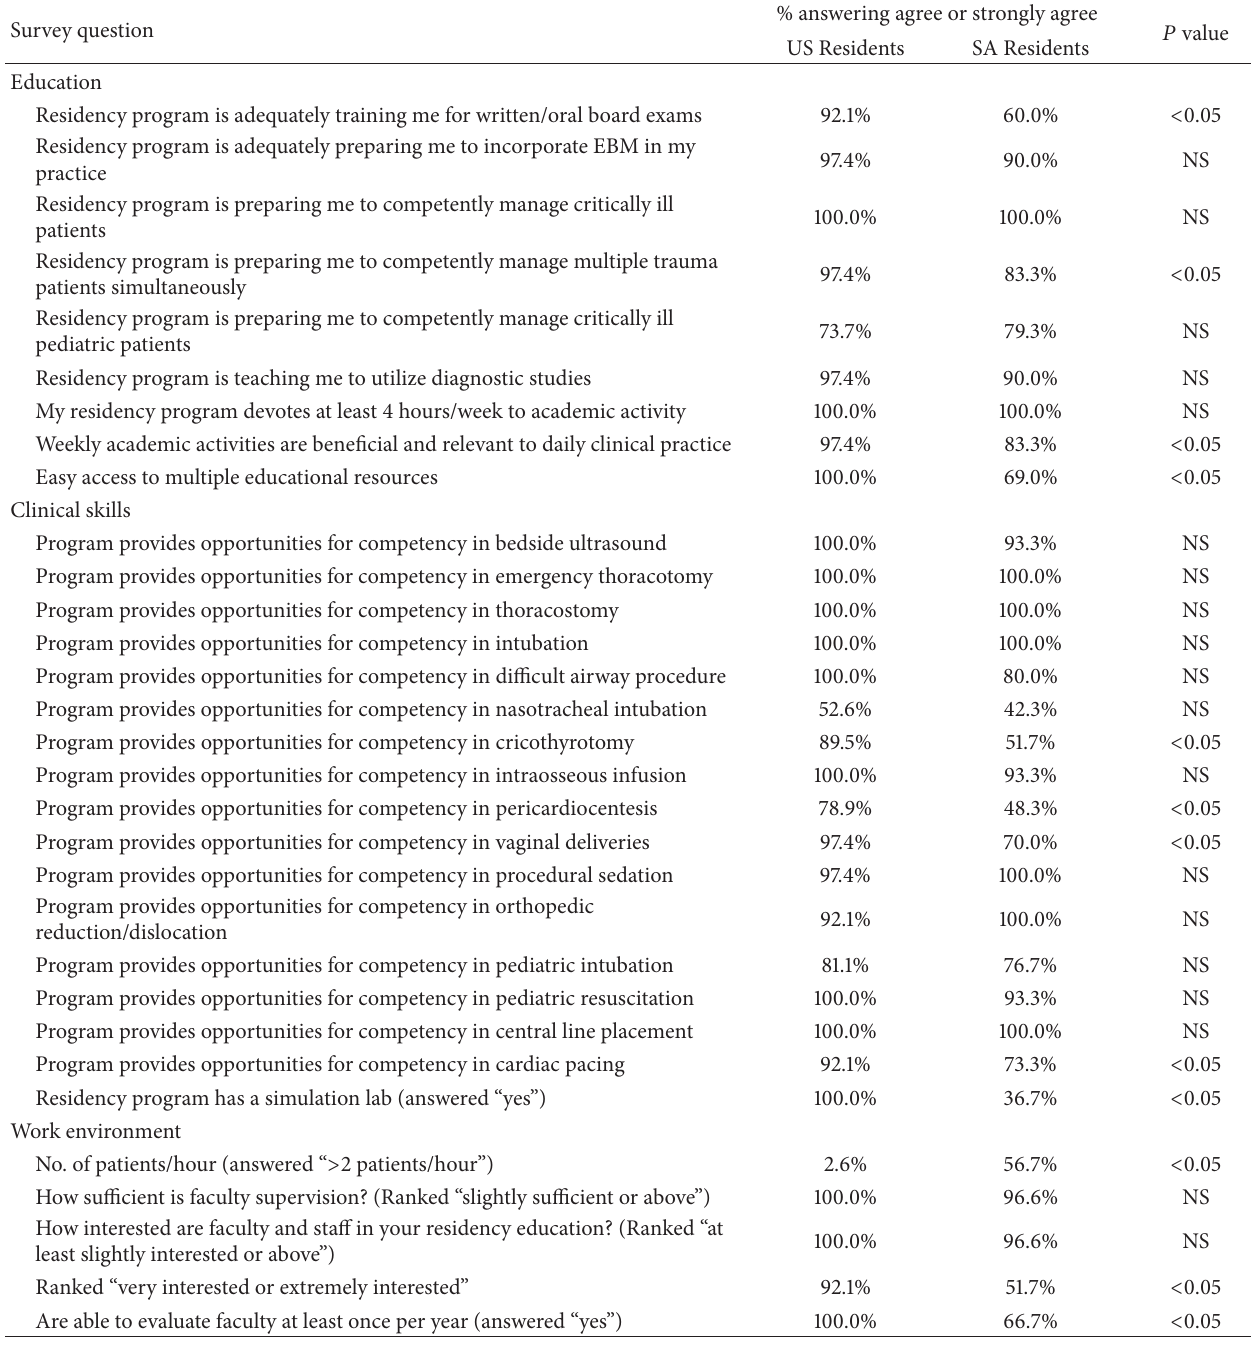
Table 1: Percent of residents answering agree or strongly agree to survey